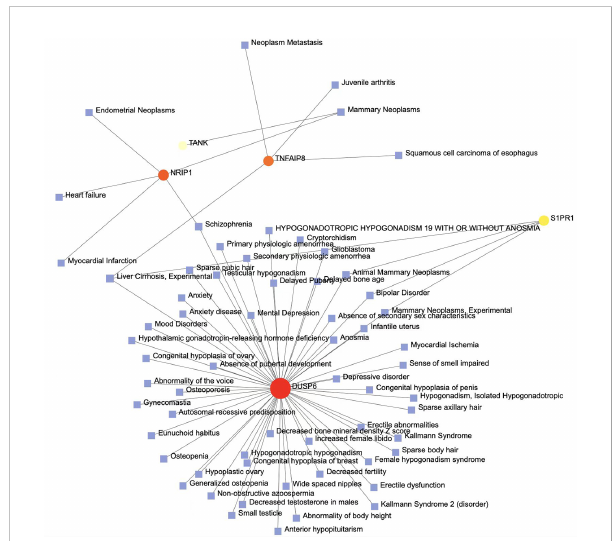
FIGURE 9 The gene – disease association networks show diseases associated with mutual DEGs. Diseases are represented by square nodes, and their associated gene symbols are represented by circular nodes. The larger the square or circle, the more important the diseases or DEGs are in this network. DEGs, differentially expressed